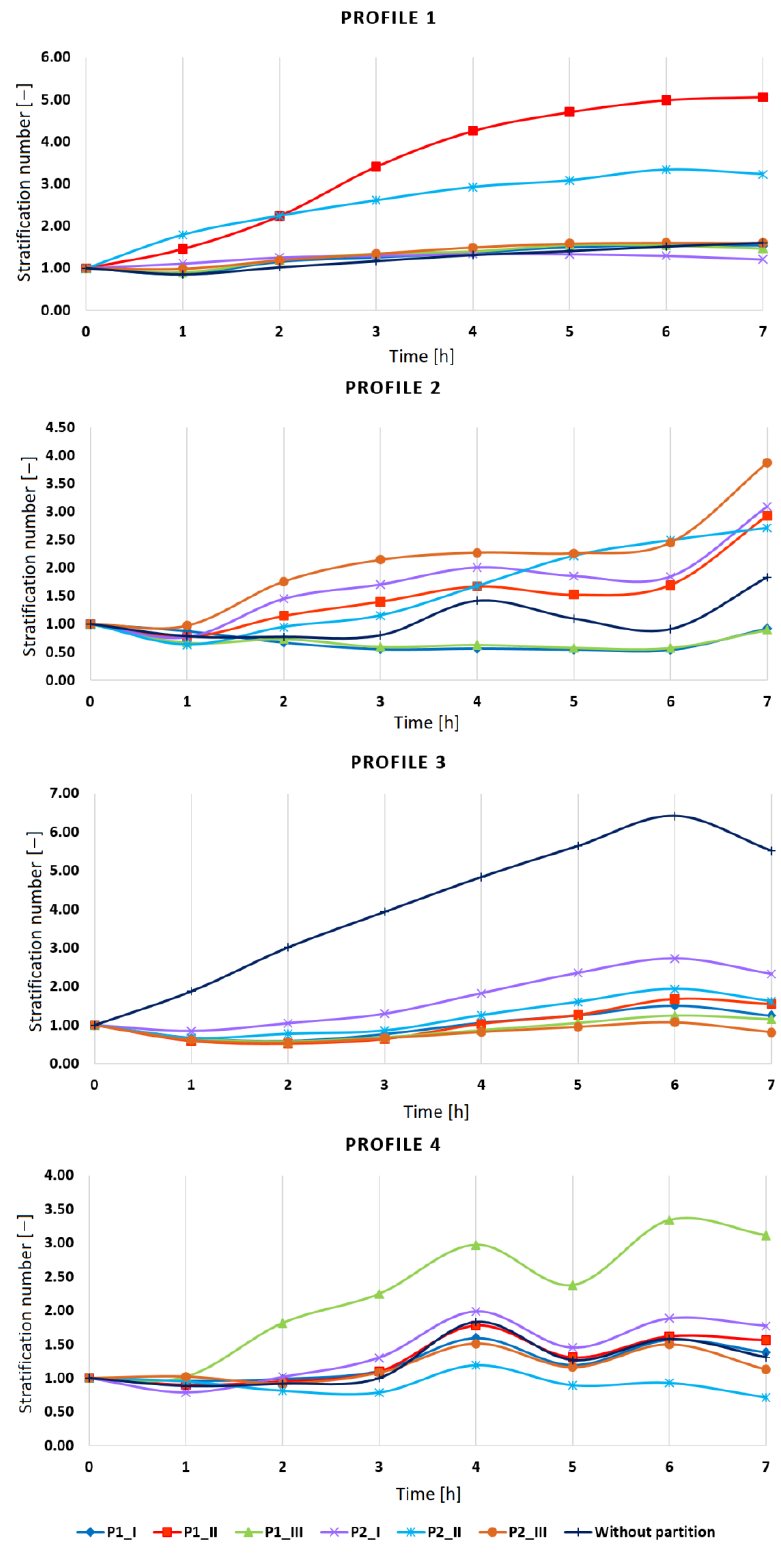
Figure 12. Stratification number inside the tank during hot water consumption.